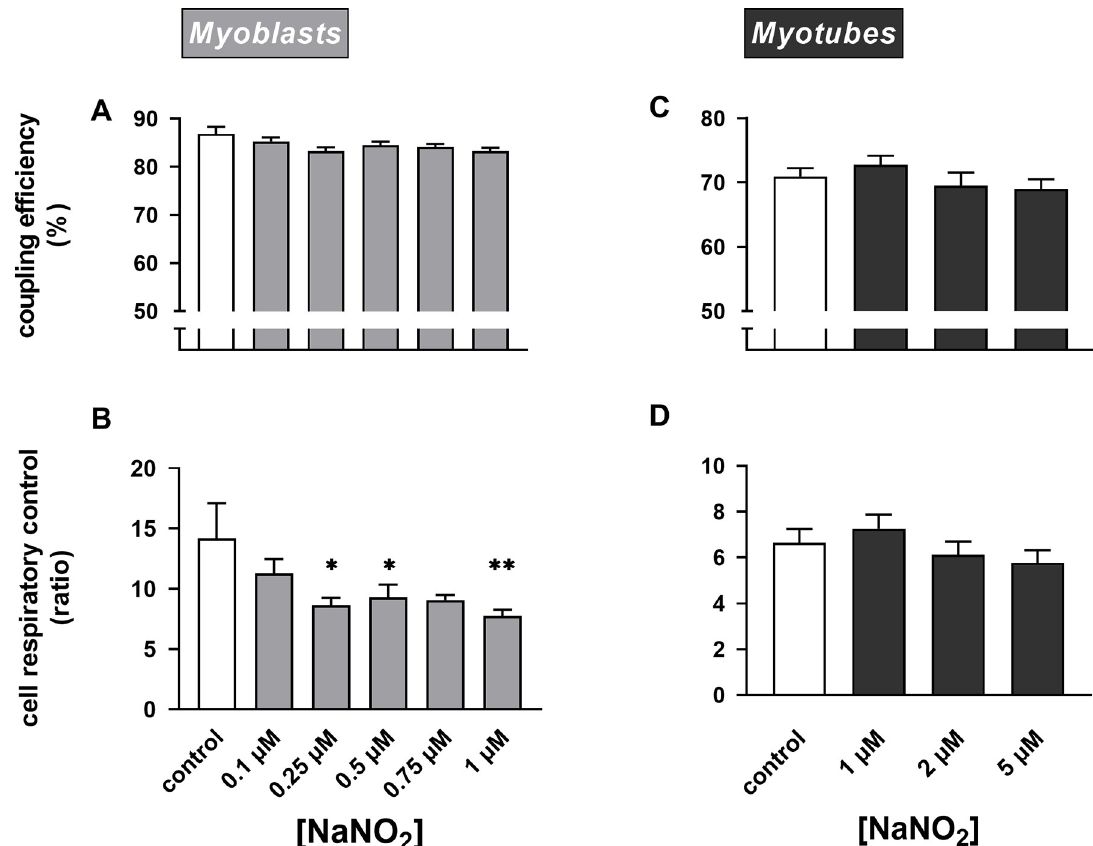
Fig 4. Nitrite lowers mitochondrial efficiency. Respiratory rates shown in Fig 3 were used to calculate coupling efficiency of oxidative phosphorylation (Panels A and C ) and cell respiratory control ratios (Panels B and D ) in static myoblasts and spontaneously contracting myotubes. Data are means ± SEM of 12–20 well measurements sampled from 4–5 independent XF assays. NaNO 2 effects were evaluated for statistical significance by combined Kruskal-Wallis and Dunn’s tests. Parameters labelled with asterisks differ significantly ( � P < 0.05 and �� P < 0.01) from the relevant (0 μ M NaNO 2 ) control